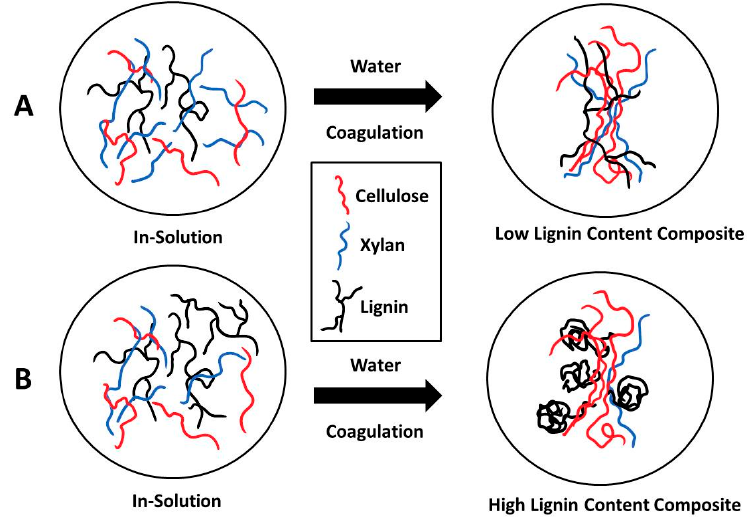
Scheme 1. Schematic representation of tri-component random coils in solution and their evolution